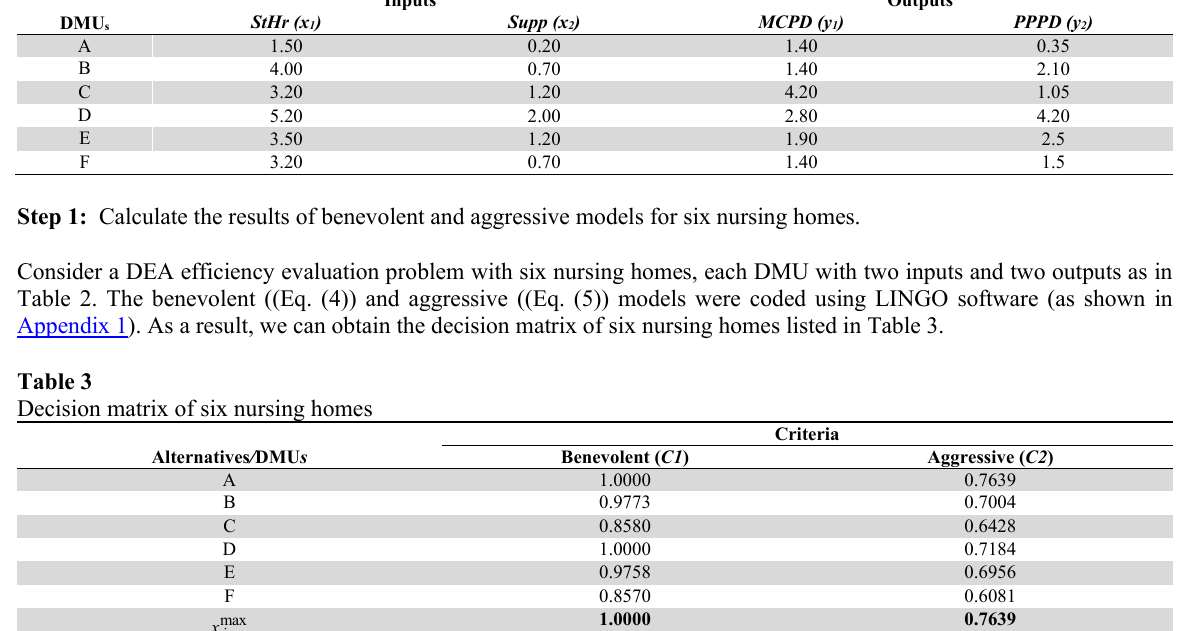
Data set of six nursing homes DMU s